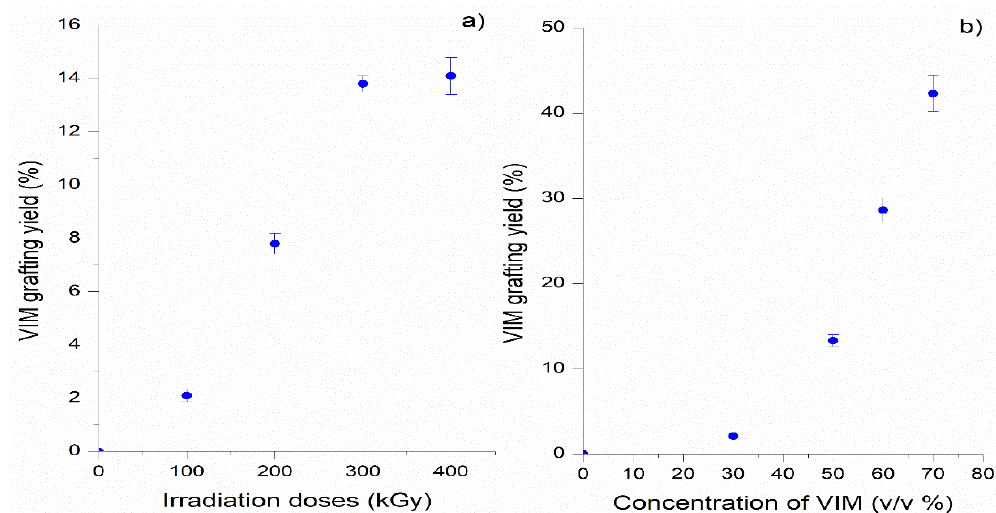
Figure 1. Grafting yield (%) of N-vinylimidazole (VIM) VIM onto polysulfone (PSU) membranes with different gamma irradiation doses: ( a ) experiment 1 (VIM concentration 50% v/v and gamma irradiation doses between 100–400 kGy); ( b ) experiment 2 (irradiation dose of 300 kGy and VIM concentration between 30–70% v/v). Standard deviation of 3 samples.